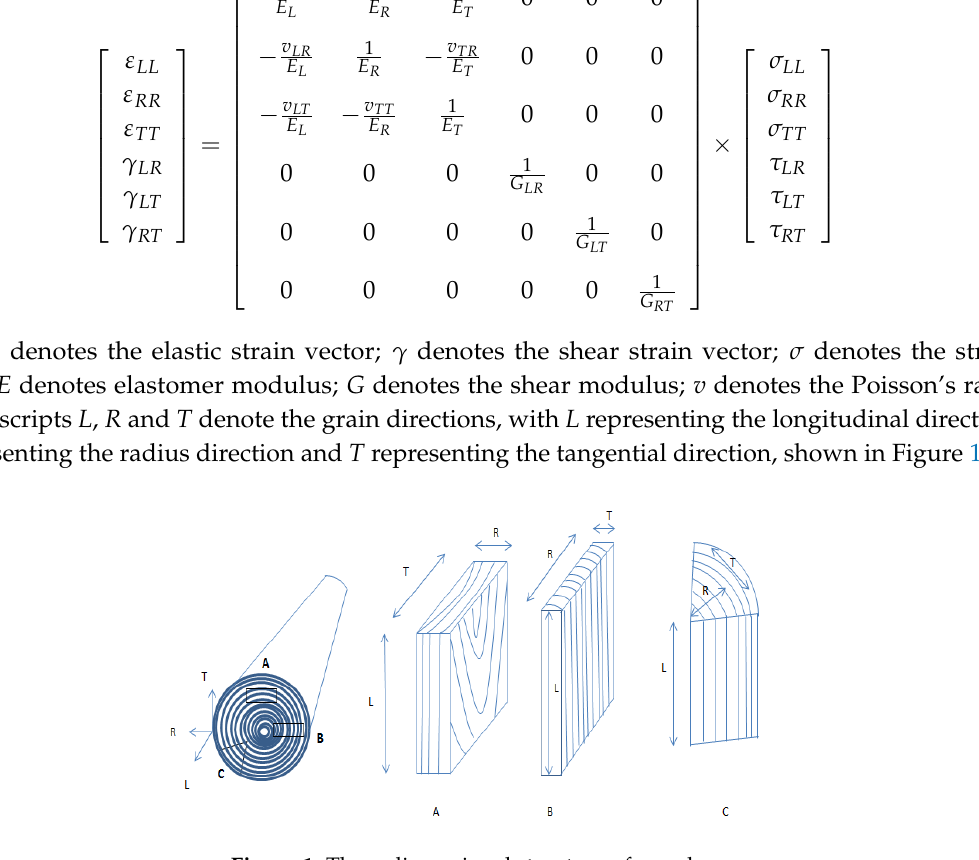
Figure 1. Three dimensional structure of wood.